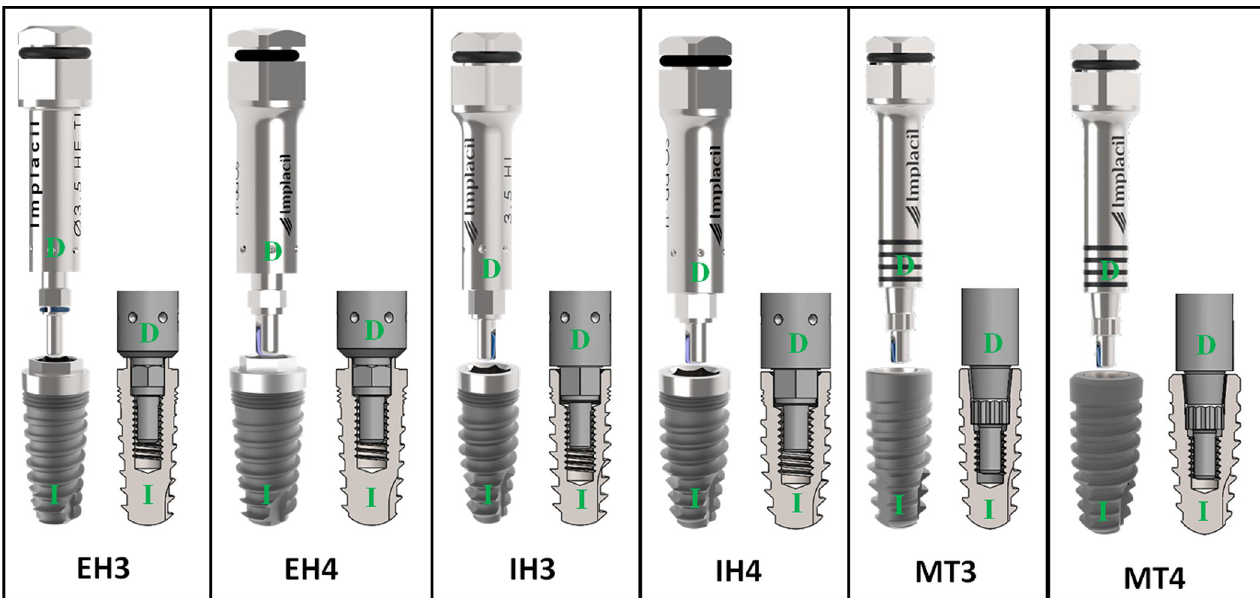
Fig 1. Images of sets and schematic connection of sets (implant and insertion driver) used for the test of each group. Green letters: D = insertion driver and I = implant.